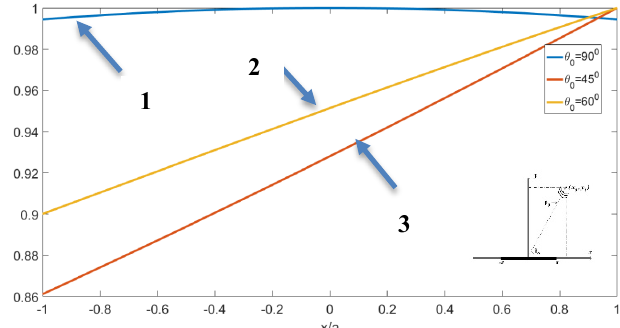
Figure 12: The normalized Fractional Current Density |𝑓y Y2$ (𝜉) | for 𝜖 = 3𝜋 and 𝜌